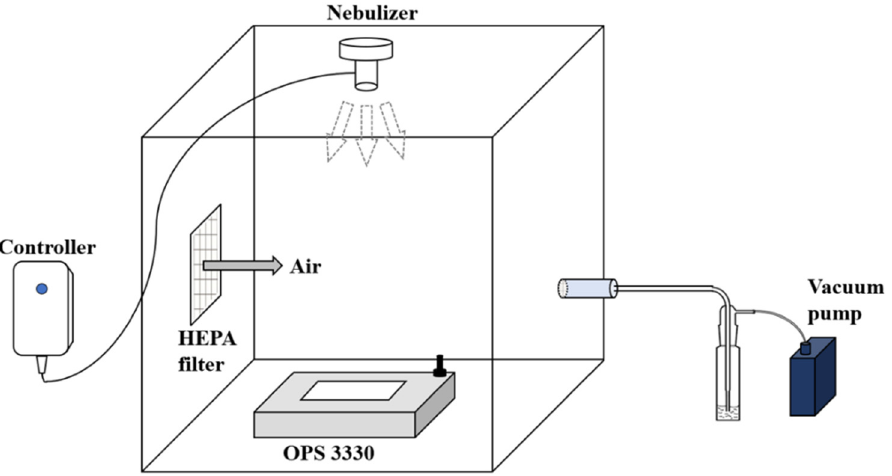
Figure 1. Aerosol exposure system of humidified biocides to the OPSS through a nebulizer.